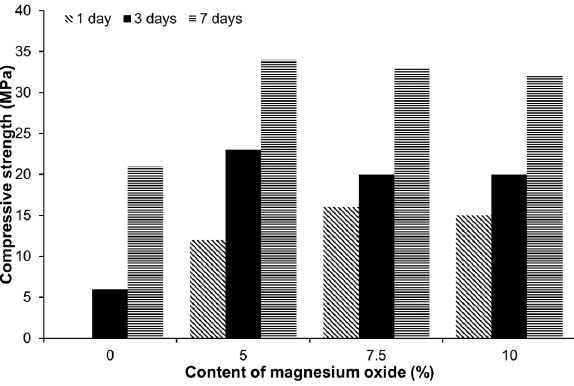
Figure 3: Effect of magnesium oxide content on compressive strength (adapted from [30])